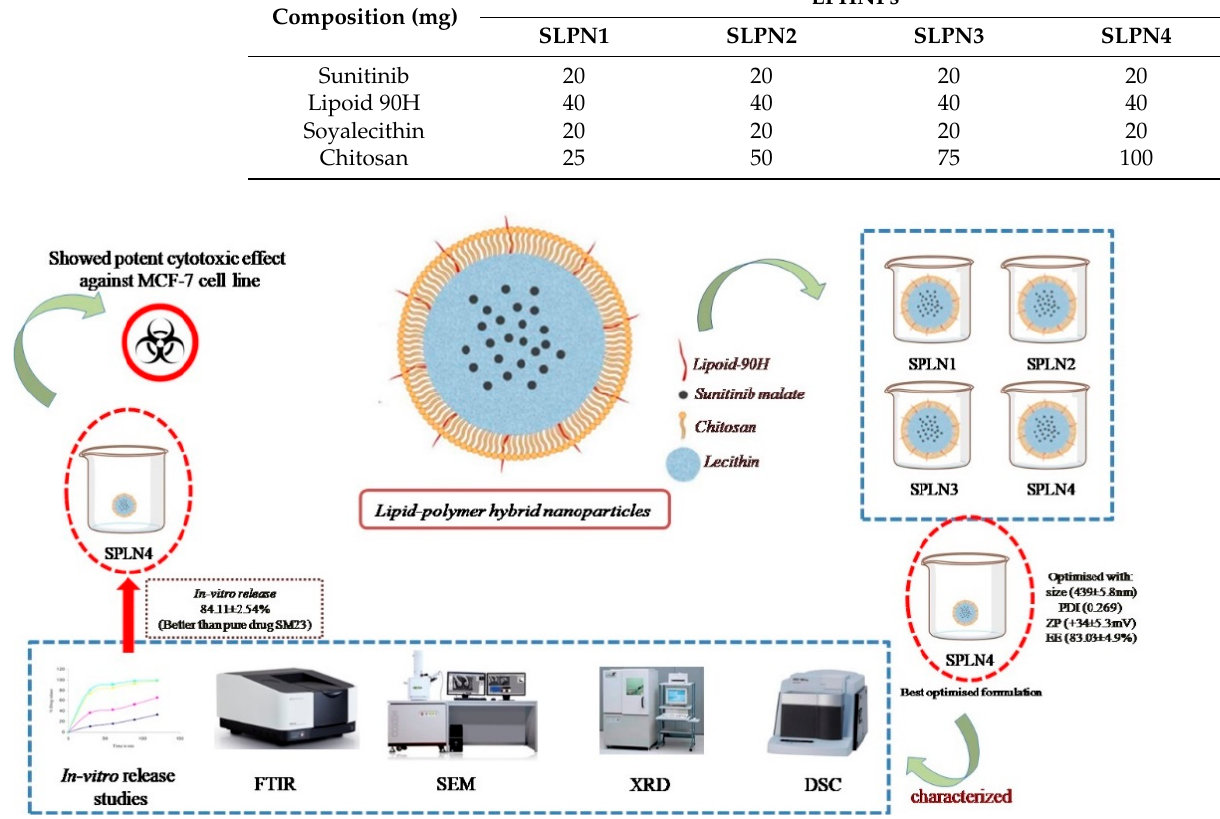
Figure 1. Schematic diagram of SLPNs synthesis.